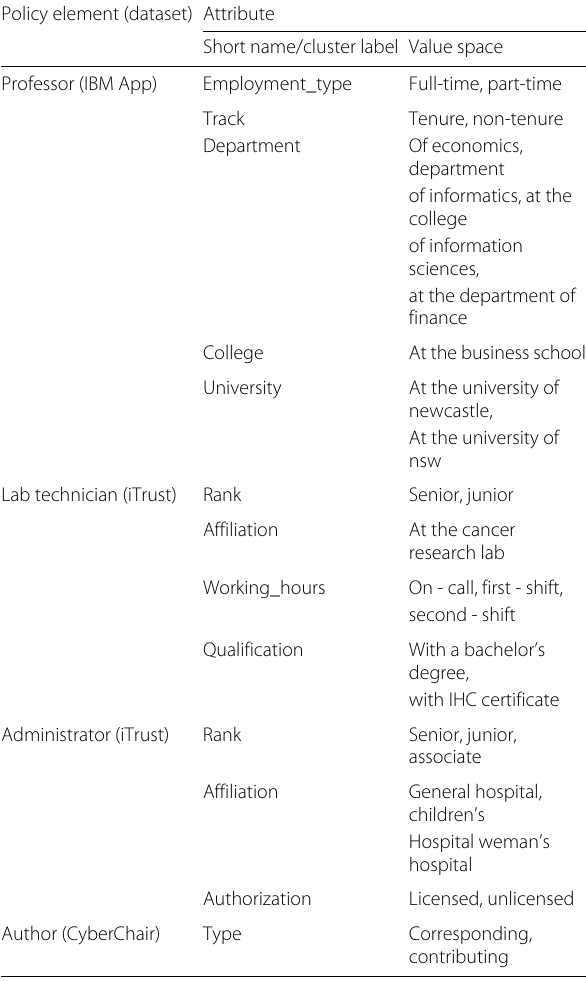
Table 7 Sample results of attributes key/value pairs of several subject elements in our